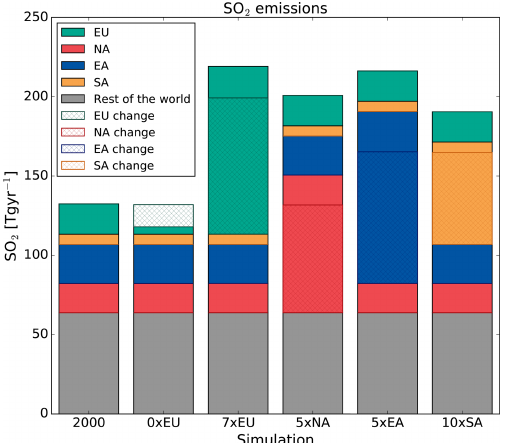
Figure 2. Global annual SO 2 and regional emissions and emission differences in the simulations. Each column shows the total global SO 2 emissions in each simulation and the colour shading indicates the contribution from each region. Hatching indicates the emission change relative to the year-2000